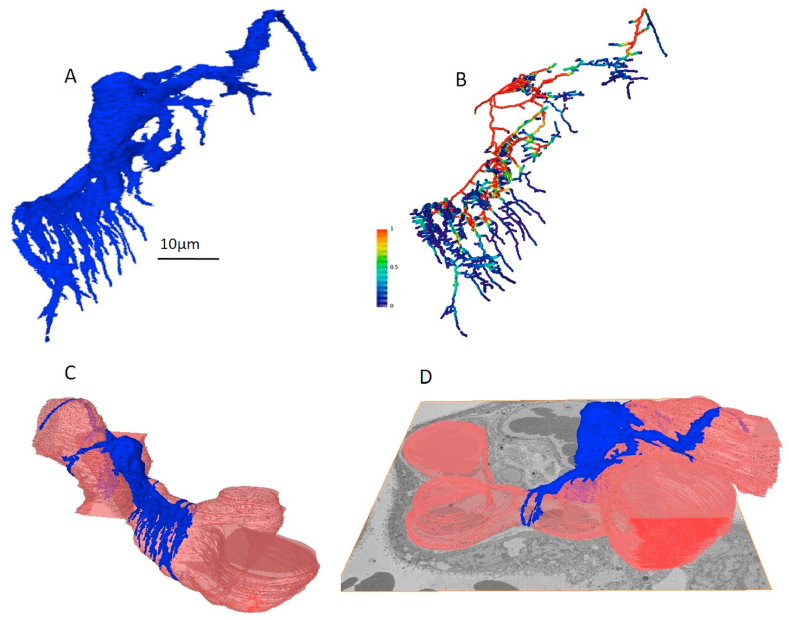
Pericytes have a close relationship with the capillary endothelium. (A) Segmentation of a whole placental pericyte (blue) including visualisation of the pericyte fingers extending from a cell body. (B) A skeletonised representation of the pericyte showing extensive branching (coloured by thickness). (C) The fingers appear not to fully encircle the capillaries and can span multiple capillary branches from one cell body (D). An animation of the pericyte being rotated can be seen in supplementary material.